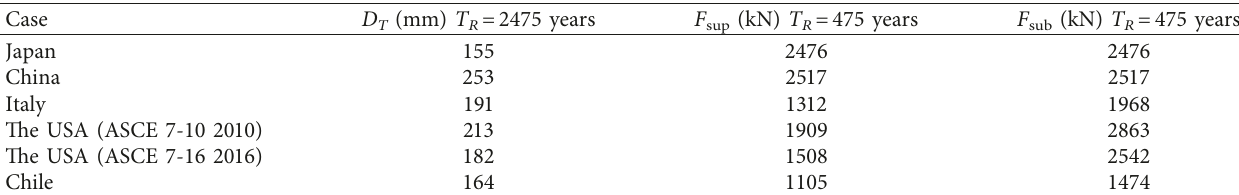
Table 20: Design parameters for static analysis of the analyzed buildings under uniform return period demand for medium seismicity ( S a (0) � 0.2g).